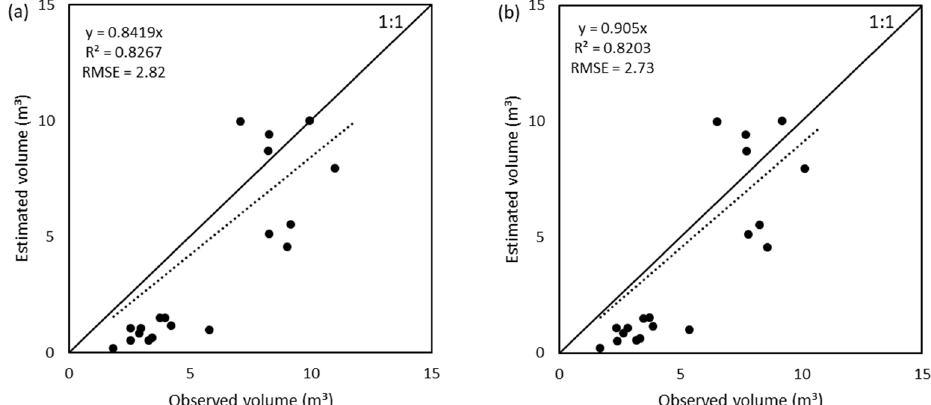
Figure 13. Scatter plot and linear fitting of the estimated volume vs. observed values (ground-truth), assuming the crown as ( a ) a sphere or ( b ) an ellipsoid. Estimated values using raster and random forest classification. Linear regression models with p < 0.05. The dashed line is the fitted linear function passing through the origin and the solid is the 1:1 line.